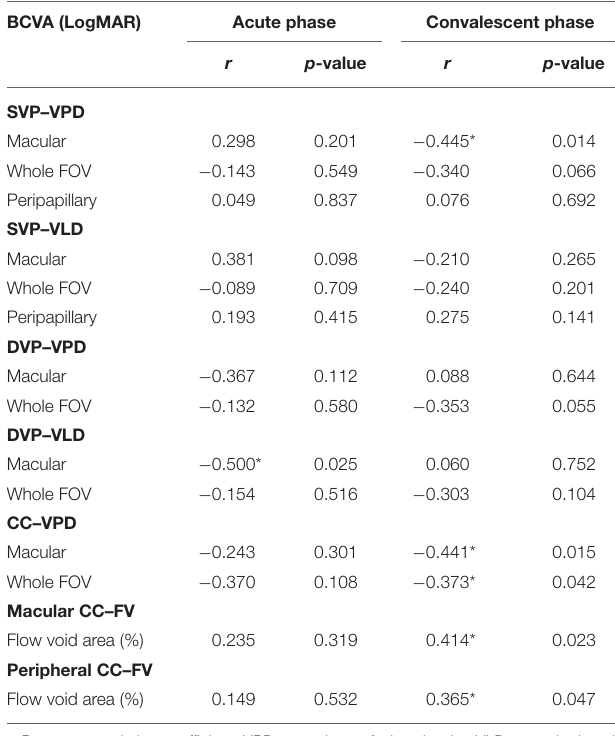
TABLE 5 | Correlation of best-corrected visual acuity with the parameters of VKH patients in acute phase and convalescent phase. BCVA